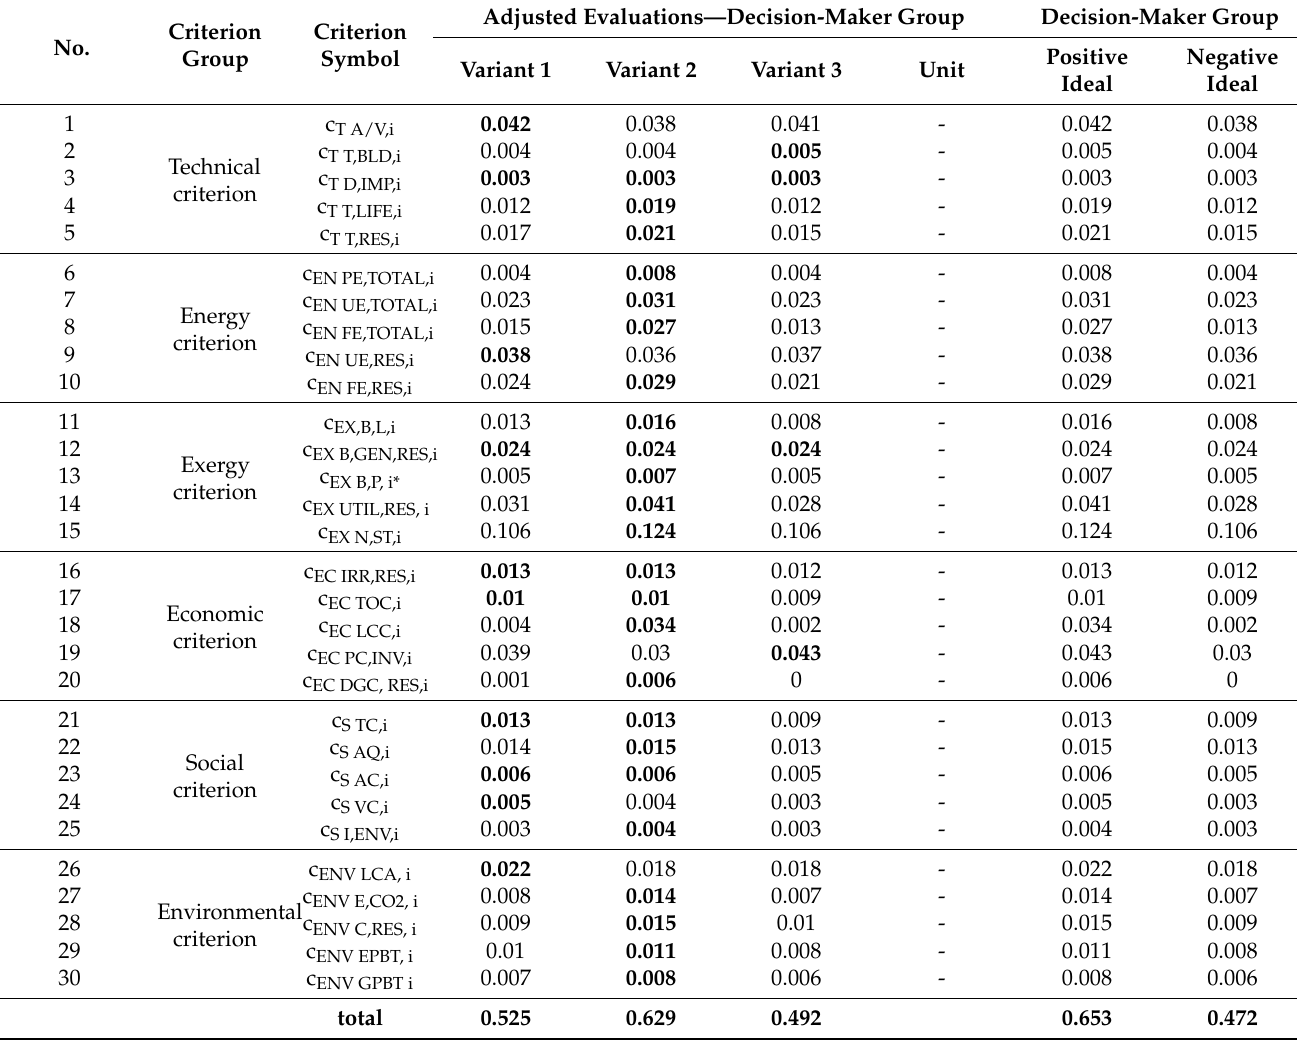
Table 10. Adjusted evaluations of the sub-criteria of evaluation for individual variants—the “All decision makers” group.